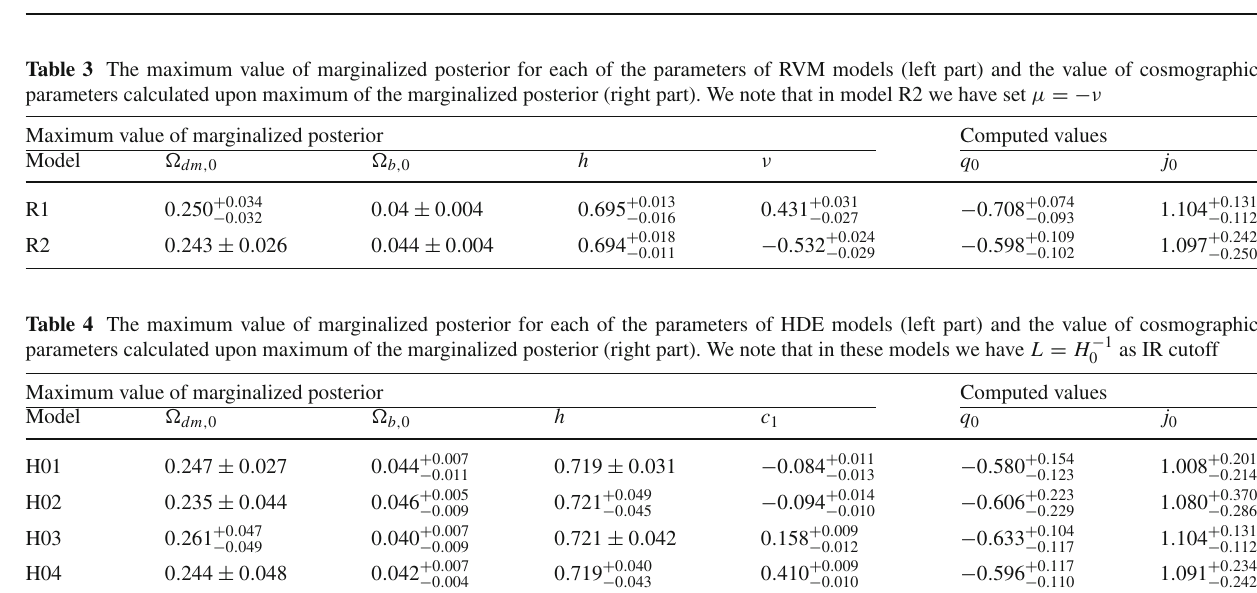
Table 2 The maximum value of marginalized posterior for each of the parameters of (cid:2) CDM model (left part) and the value of cosmographic parameters calculated upon maximum of the marginalized posterior (right part) Maximum value of marginalized posterior